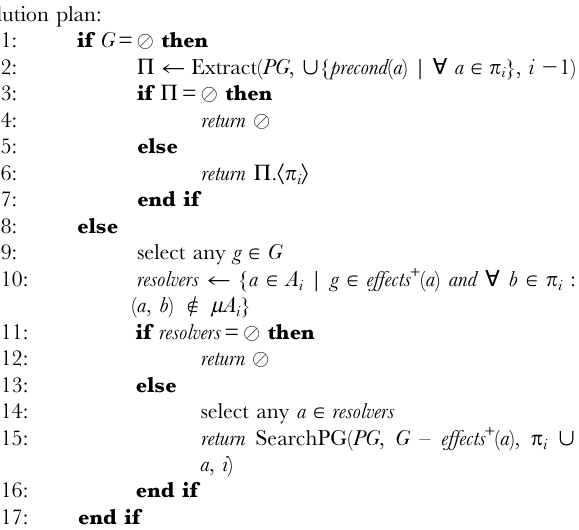
Algorithm 4 SearchPG(PG, g, p i , i): Let PG be a planning graph